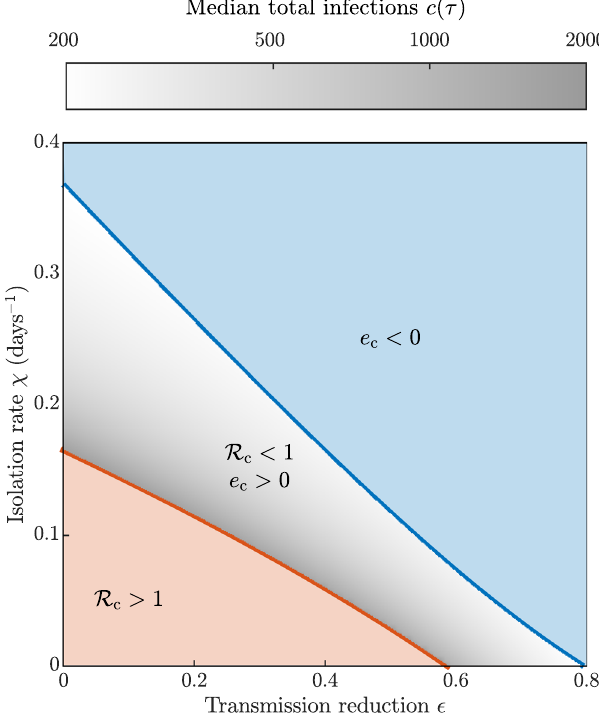
Fig. 5 The effect of spatially homogeneous controls on subthreshold epidemic size. The SEPIAR model has been simulated seeding one by one each of the 107 Italian provinces with an initial abundance of exposed individuals E i (0) = 100 (details as in Fig. 4a), for parameter combinations resulting in R c < 1 (above the red solid curve) and e c > 0 (below the blue dashed curve). Gray shading represents the total number of cases over the whole national territory c ( τ ) up to the end of the simulation timespan ( τ = 90 days), evaluated as the median of the values obtained with different initial conditions (i.e., outbreaks starting from each of the different provinces). Parameters as in Table 2, with ϵ i = ϵ , ξ ij = 0.5, χ X i ¼ χ for all i ’ s, j ’ s, and X ∈ { E , P , I , A }, and w X = 1 ( X ∈ { E , P , I , A }).